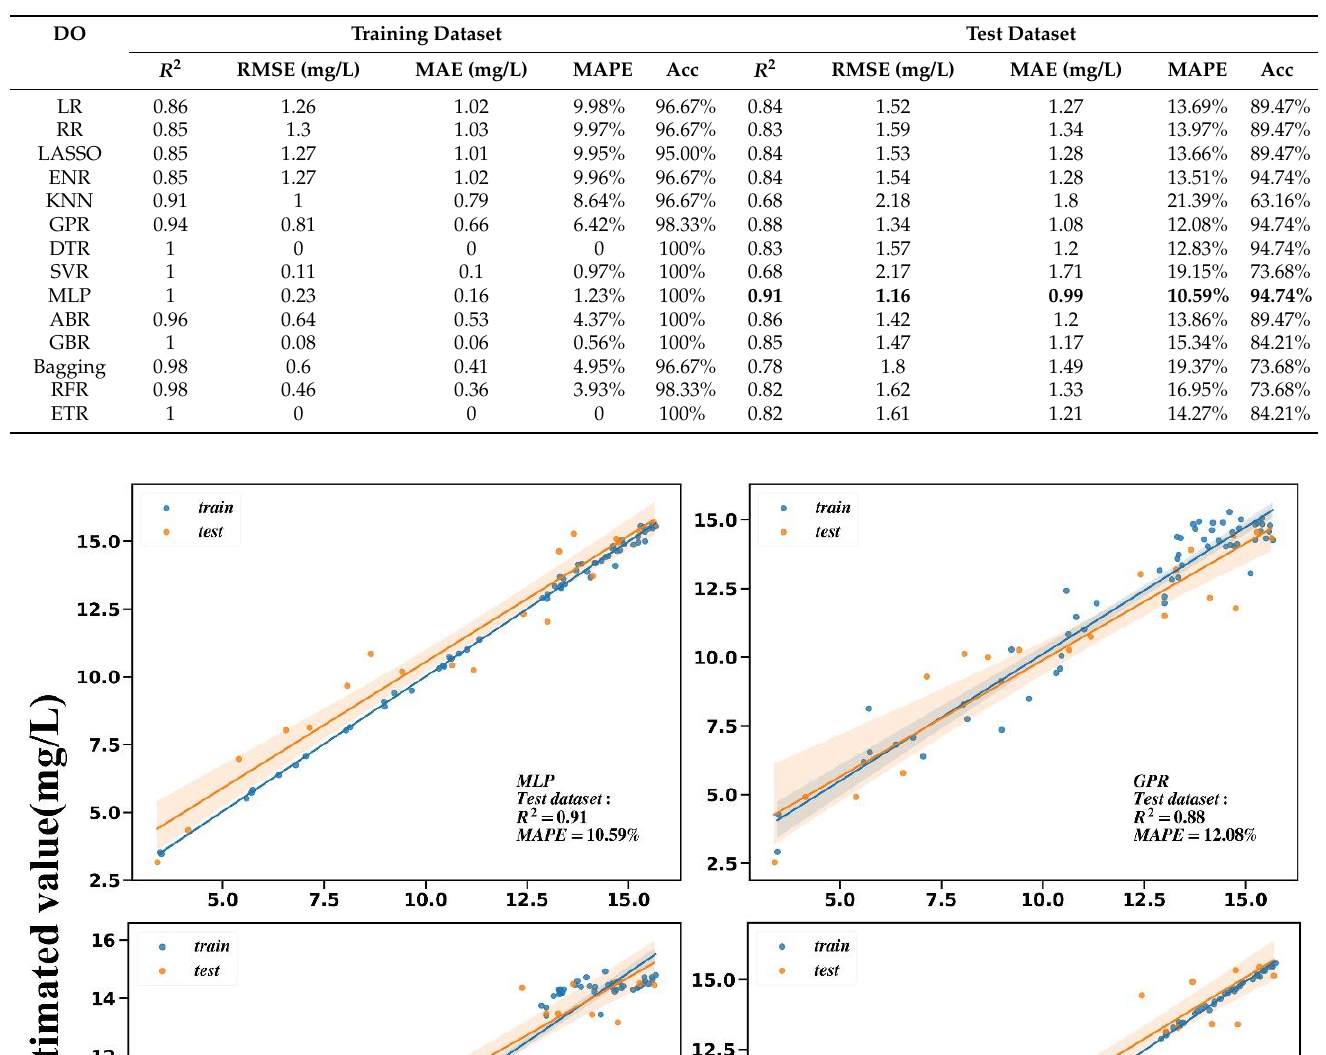
Table 8. Performance of fourteen models on DO training dataset and test dataset.